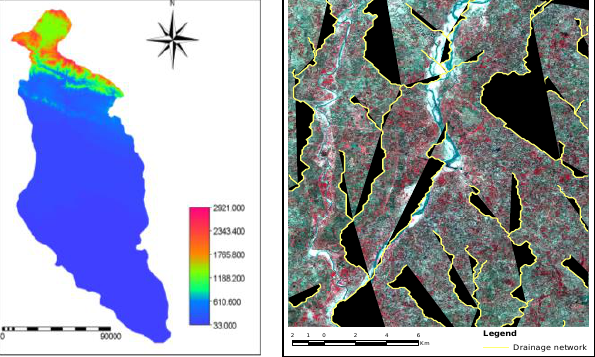
Fig.3.1a: SRTM 90 m DEM and 3.1b: Image showing derived streams and actual river as seen in LISS-III data.